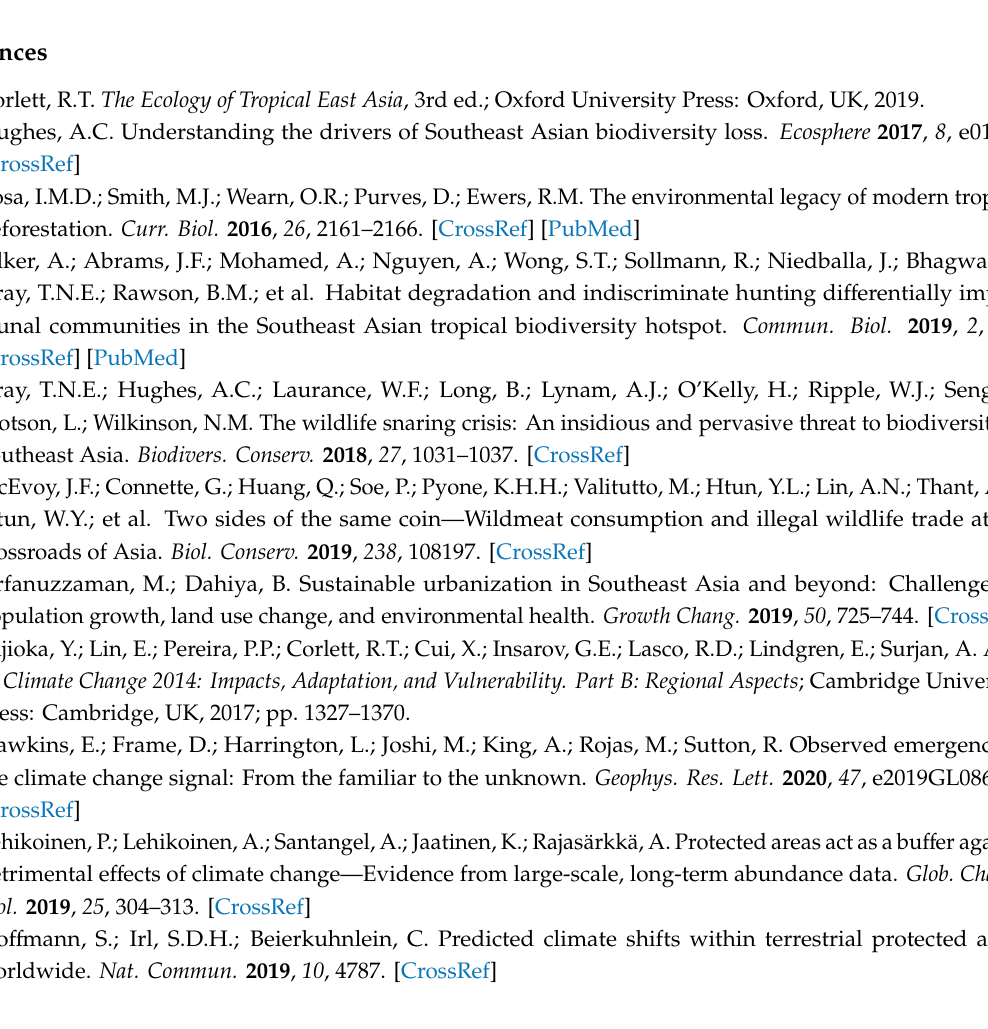
bioclimatic zone for 2050 and 2070, Table S16: Percentage shift of each protected area to di ff erent bioclimatic strata for 2050 and 2070, Table S17: Projected change in areal extent of bioclimatic zones in each protected area by 2050, Table S18: Projected change in areal extent of bioclimatic zones in each protected area by 2070, Figure S1: Change in mean annual temperature as projected for the year 2050, Figure S2: Change in mean annual temperature as projected for the year 2070, Figure S3: Change in maximum temperature of the warmest month as projected for the year 2050, Figure S4: Change in maximum temperature of the warmest month as projected for the year 2070, Figure S5: Change in mean annual precipitation as projected for the year 2050, Figure S6: Change in mean annual precipitation as projected for the year 2070, Figure S7: Bioclimatic stratification of Myanmar based on spatially interpolated weather station data and as projected for 2050, Figure S8: Bioclimatic stratification of Myanmar based on spatially interpolated weather station data and as projected for